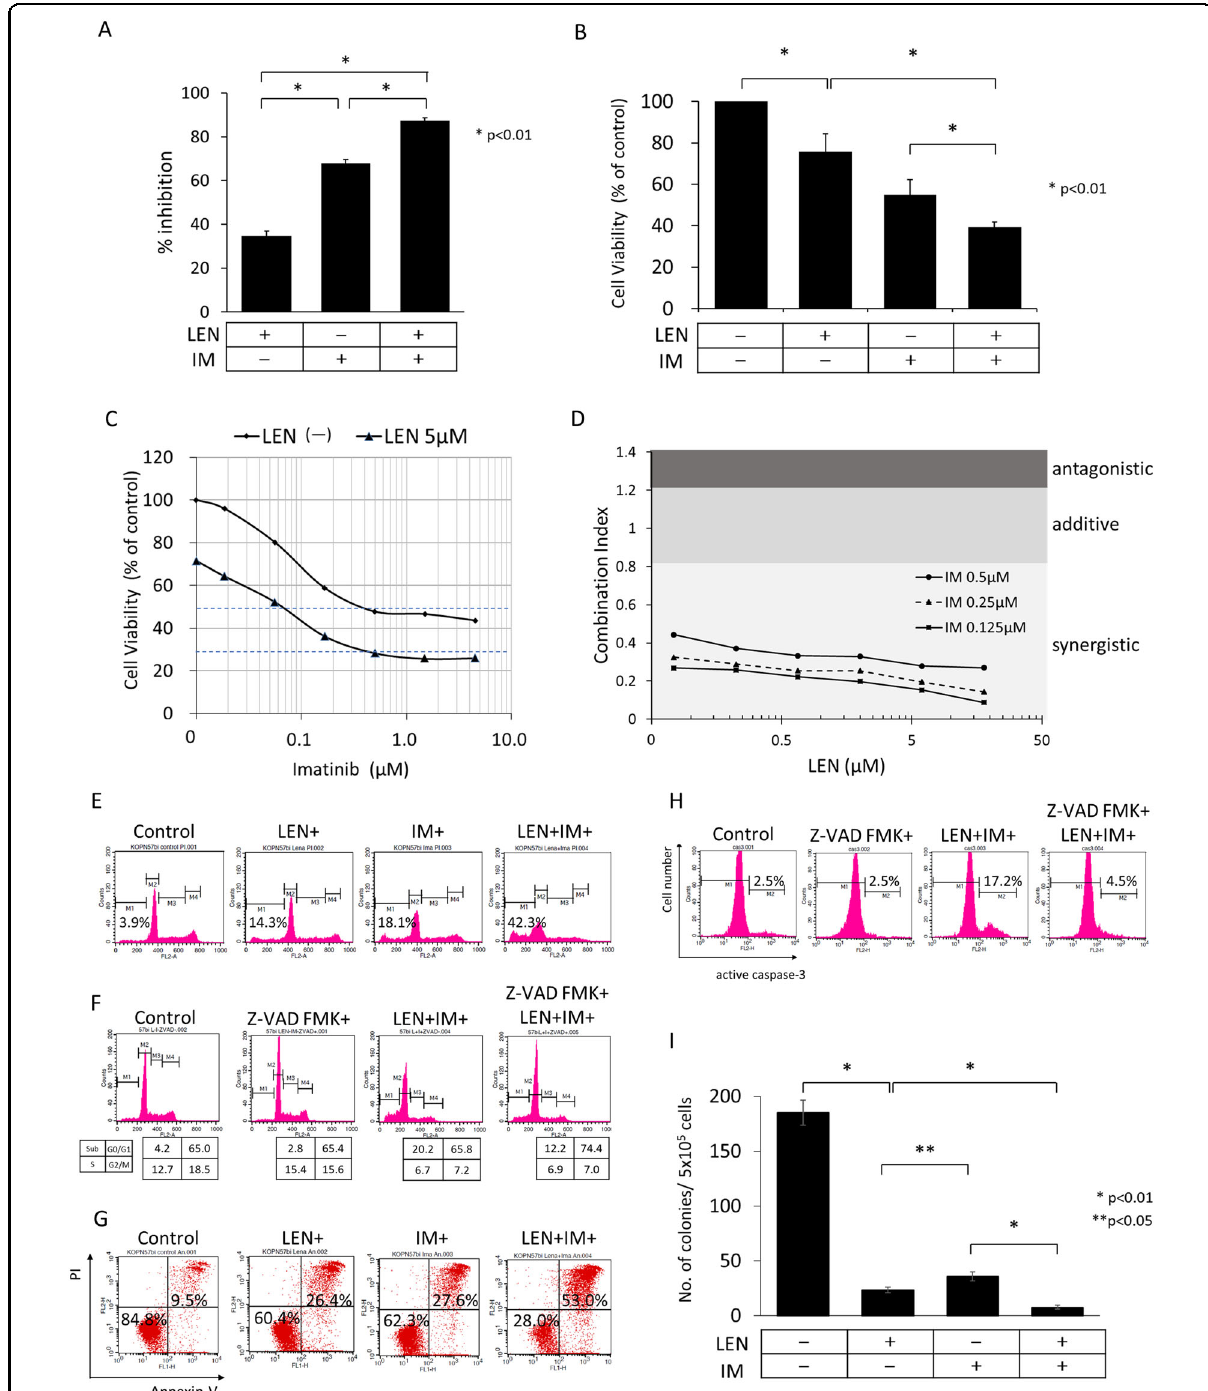
analysis using the IM-resistant SU/SR cell line with T315I mutation (expressing Ik6 only), the PO effect was mark- edly potentiated in the presence LEN (Fig.